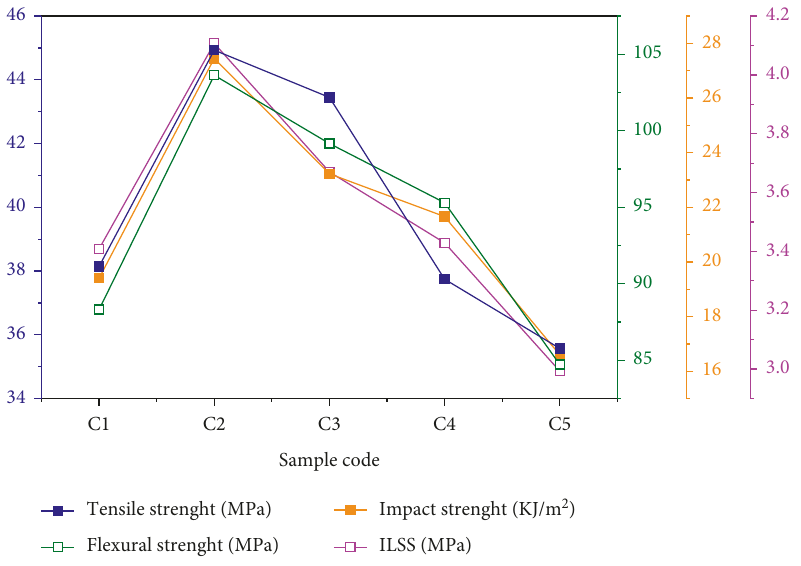
Figure 3: Mechanical test result after the experiment.